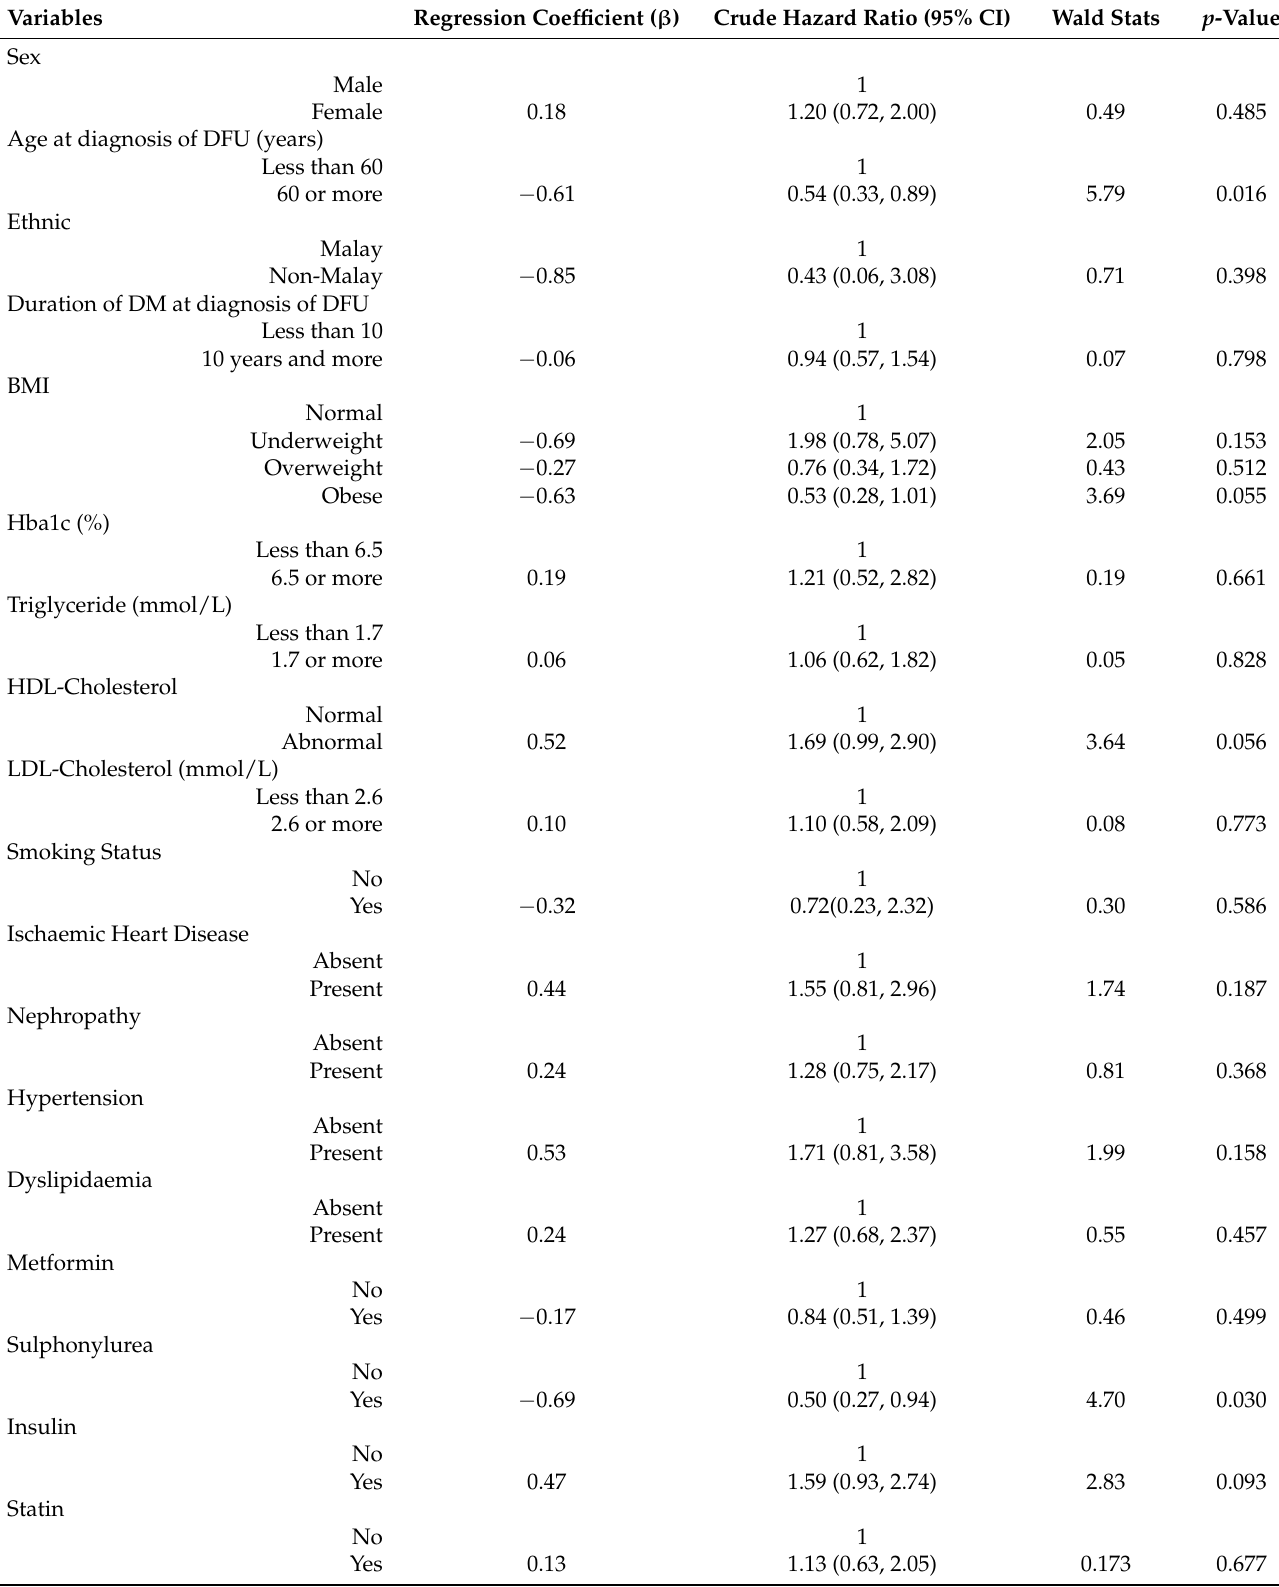
Table 2. Univariate analysis using Simple Cox